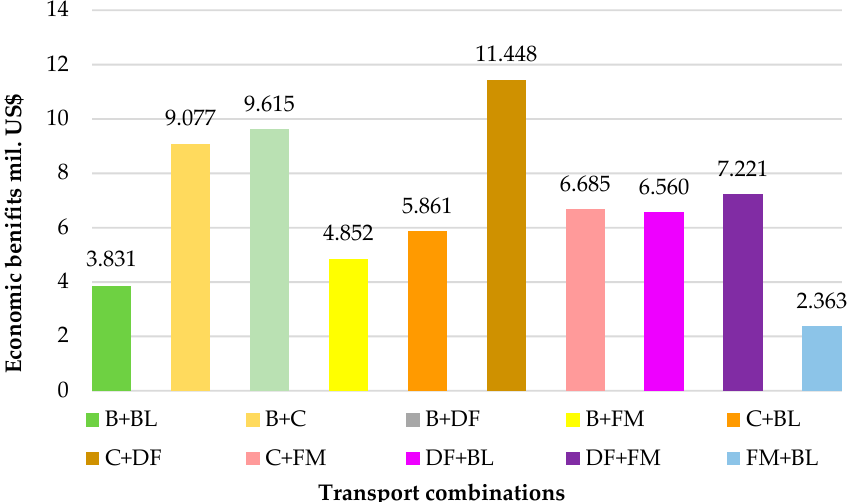
Figure 24. Estimated economic benefits for the characteristic combination of transport over the 25-year ship’s lifetime.